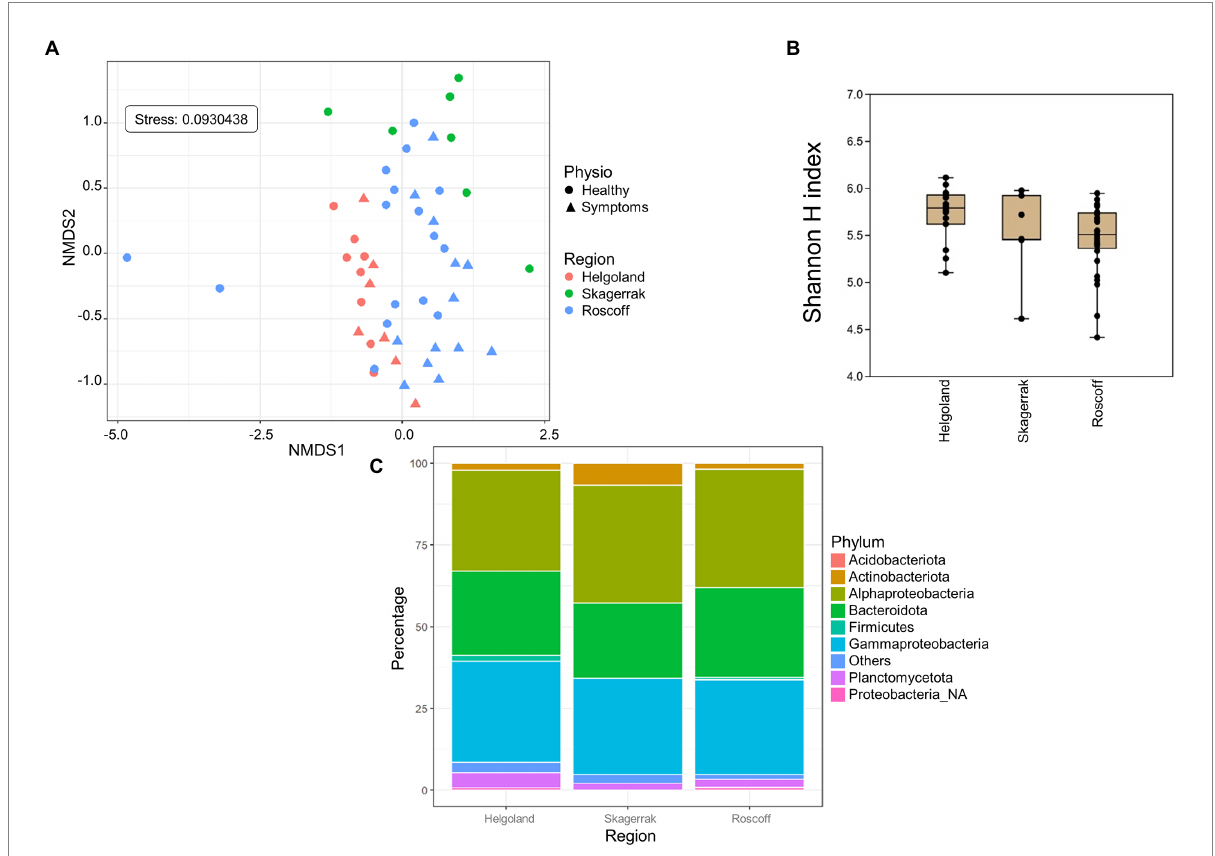
FIGURE 3 Region analysis. (A) NMDS analysis of the microbiome composition. Results show a clear separation of the samples according to their origin (PERMANOVA, p = 0.001). (B) Box plot of alpha-diversity (Shannon H index) across different sample types calculated at the ASV level. Error bars correspond to the range; n = 51; conditions do not differ significantly (Kruskal–Wallis test, p > 0.05). (C) Microbiome composition of samples from Helgoland, Skagerrak, and Roscoff at the phylum level. Bars show the relative abundance of 16S rRNA gene metabarcoding sequences; all phyla were detected in all sample types, and only their relative abundance varied. Proteobacteria_NA : unclassified